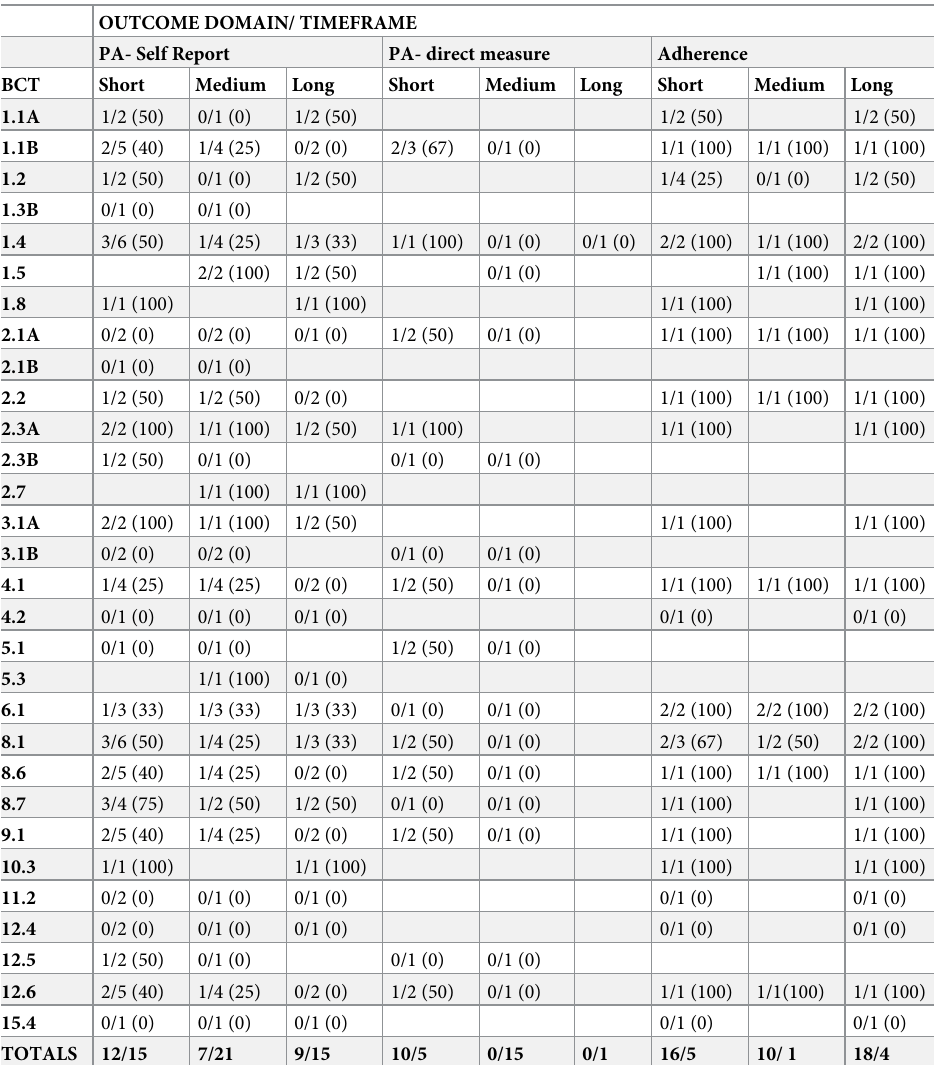
Table 4. BCT effectiveness